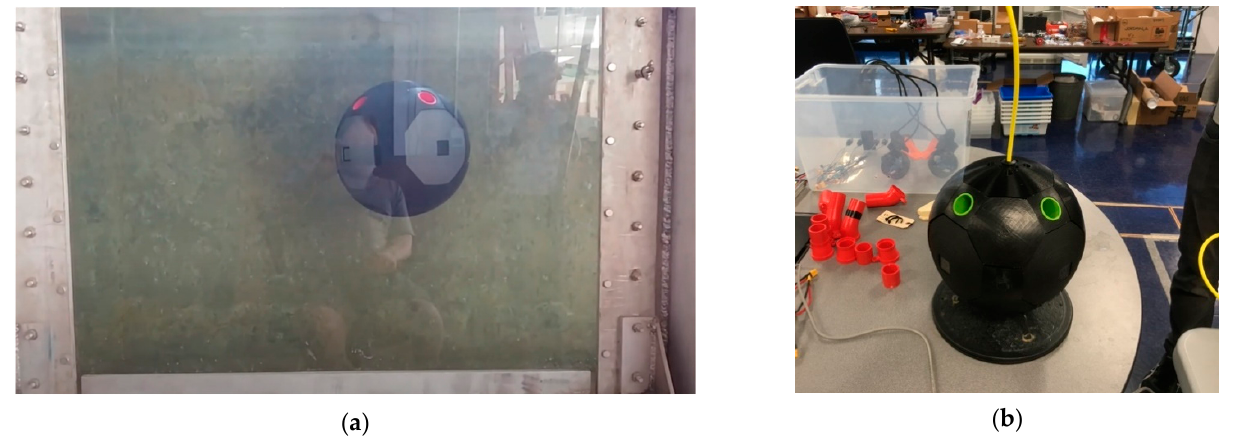
Figure 15. WIEVLE testing ( a ) Initial open-loop, untethered tank testing ( b ) Modified hull for tethered testing.